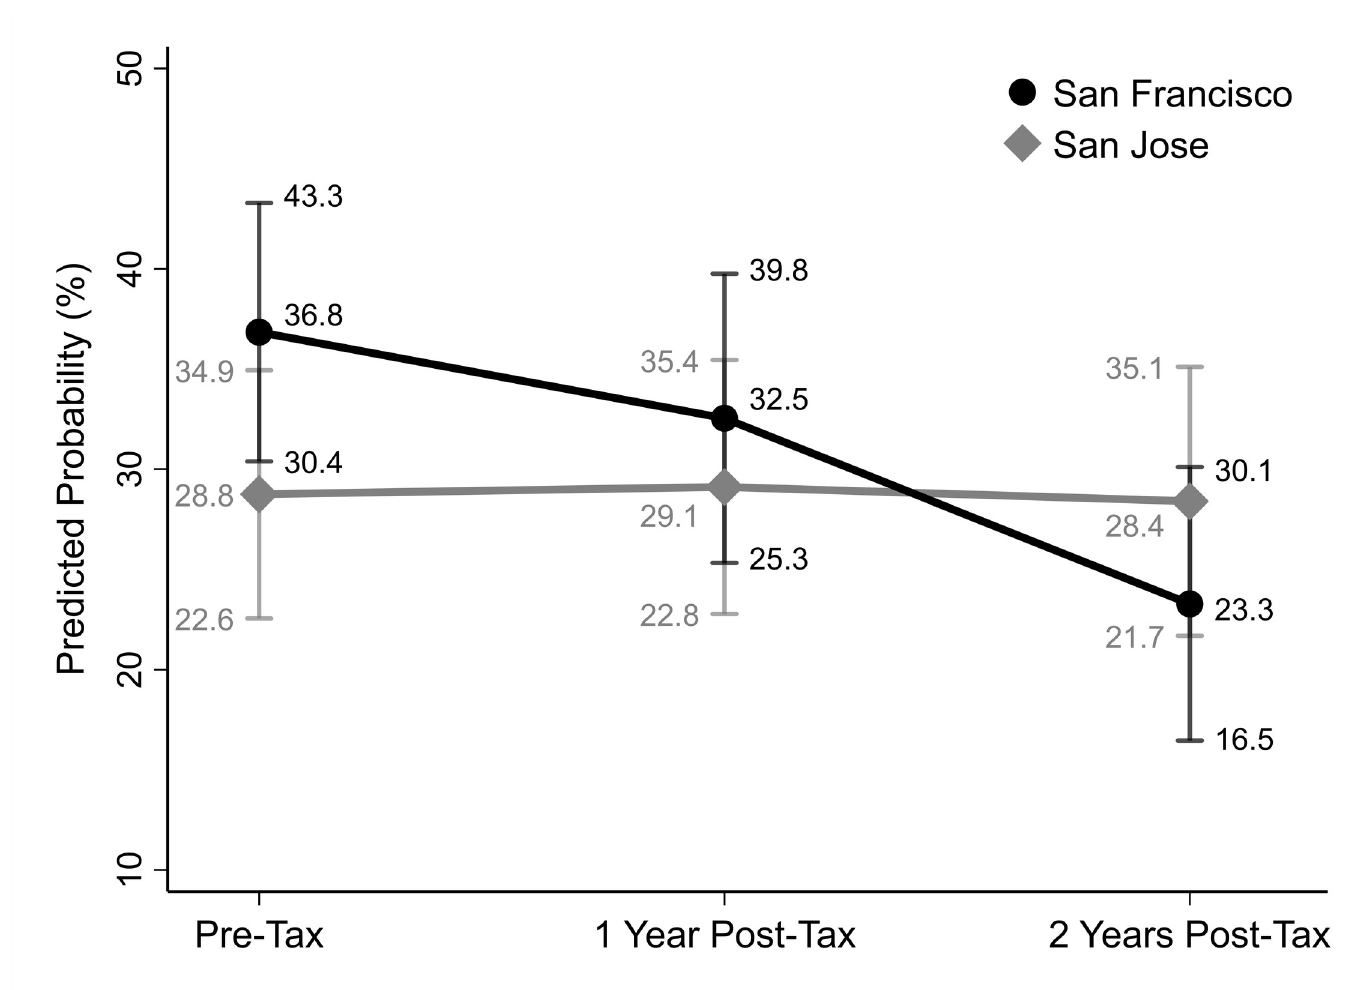
Fig 2. Average adjusted predicted probability of high SSB consumption a with 95% confidence intervals in San Francisco and San Jose before, one, and two years after San Francisco’s sugar sweetened beverages tax implementation (n = 1,443). Note: Results based on binomial GLM with 2-way interactions between time